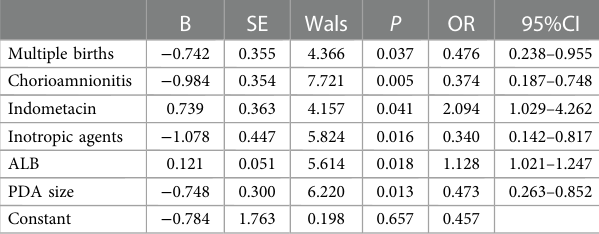
TABLE 2 Multivariate logistic regression analysis of risk factors of drug treatment